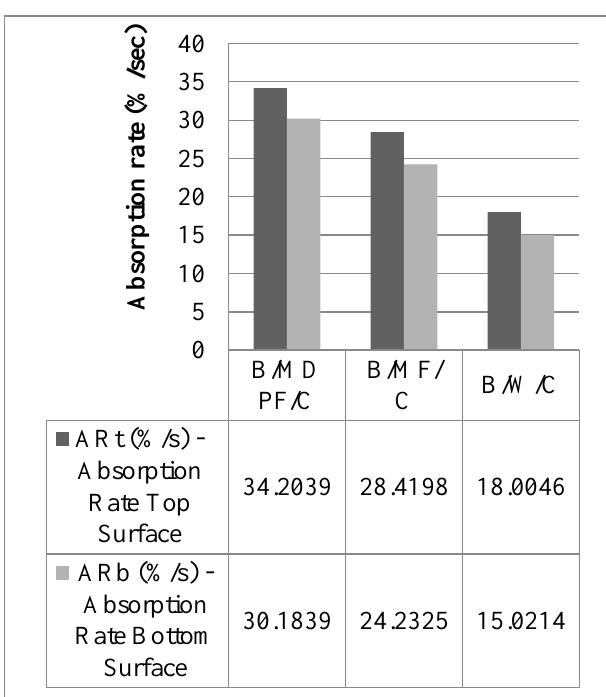
Fig. 2. Wetting time of absorption rate of trilayer knitted fabrics